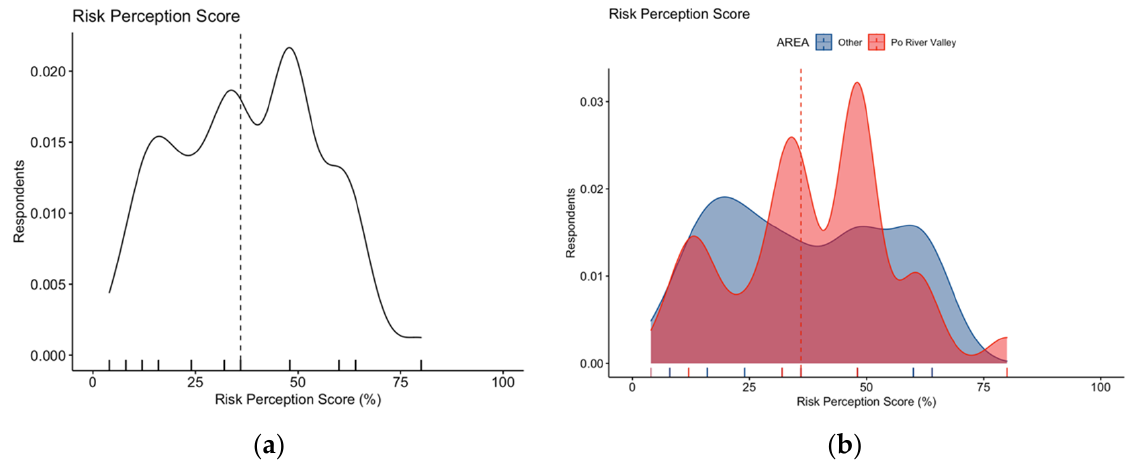
Figure 4. Density plots for: ( a ) risk perception score in 254 Italian physicians participating in the survey; ( b ) risk perception score broken down by residence of the respondents. The estimate was substantially skewed (D’Agostino–Pearson’s normality test p -value < 0.001), with no differences in score estimates for participants residing vs. those not residing in endemic areas (38.4% ± 17.0 vs. 36.9% ± 18.1 for individuals from Po River Valley vs. other Italian regions, Mann–Whitney p value = 0.644). Dotted line represents median